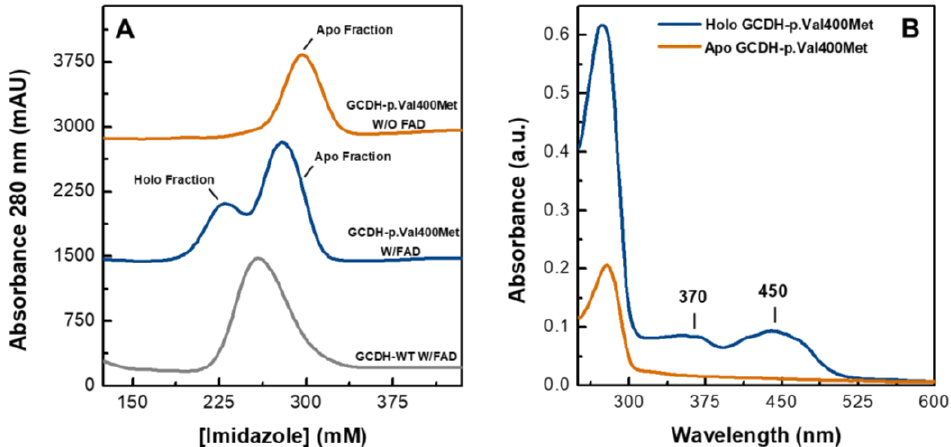
Figure 1. Flavin adenine dinucleotide (FAD) binding state in glutaryl-coenzyme A (CoA) dehydrogenase (GCDH)-p.Val400Met. ( A ) His-tag affinity chromatogram, bound proteins eluted with a linear gradient of imidazole from 10 to 500 mM. Elution profile of the soluble extract incubated overnight with FAD (W/FAD) in the case of wild-type (WT, gray line) and p.Val400Met (blue line) and also without the incubation step (W/O) for the variant (orange line). ( B ) UV–visible spectra of the GCDH-p.Val400Met variant, holoprotein (blue line) and apo fraction (orange line) from the His-trap column.